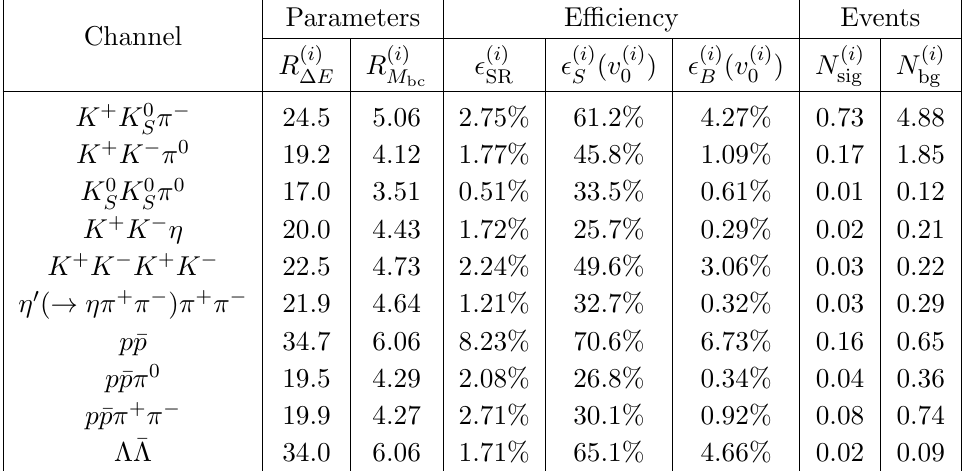
Table 2 . Results of the optimization of the selection requirements for the channel B 0 The expected number of signal events is calculated assuming 10 (cid:0) 5 and equal partial widths of the decays B + h c (cid:13) ) = 1 : 0 (cid:2) The e(cid:14)ciencies and expected numbers of signal and background events are calculated for the train- ing sample. The signal-region half-axes R ( i )